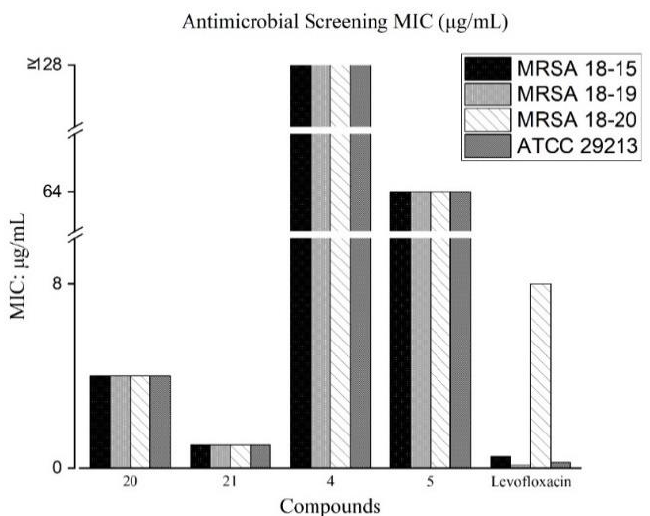
Figure 3. In vitro antibacterial activity of ocotillol- type derivatives (MIC: μg/mL).